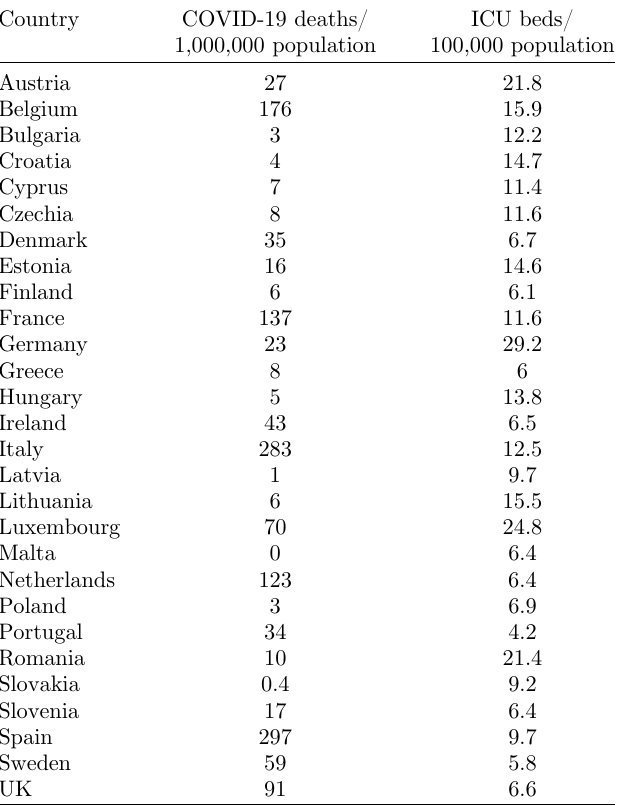
Table 1. COVID-19 deaths/1,000,000 population and ICU beds/100,000 population in the EU